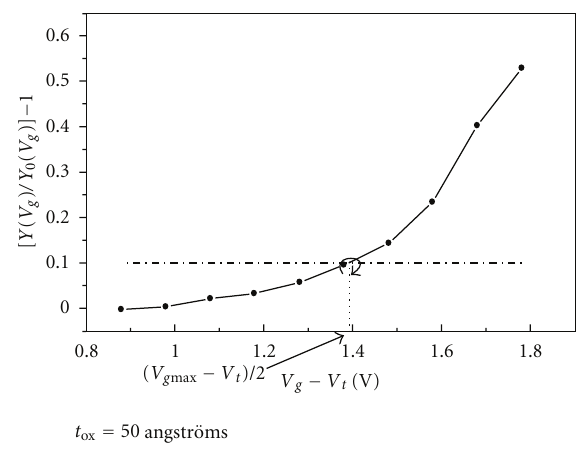
Figure 3: Characteristic Y ( V g ) to Y 0 ( V g ) ratio versus gate voltage.